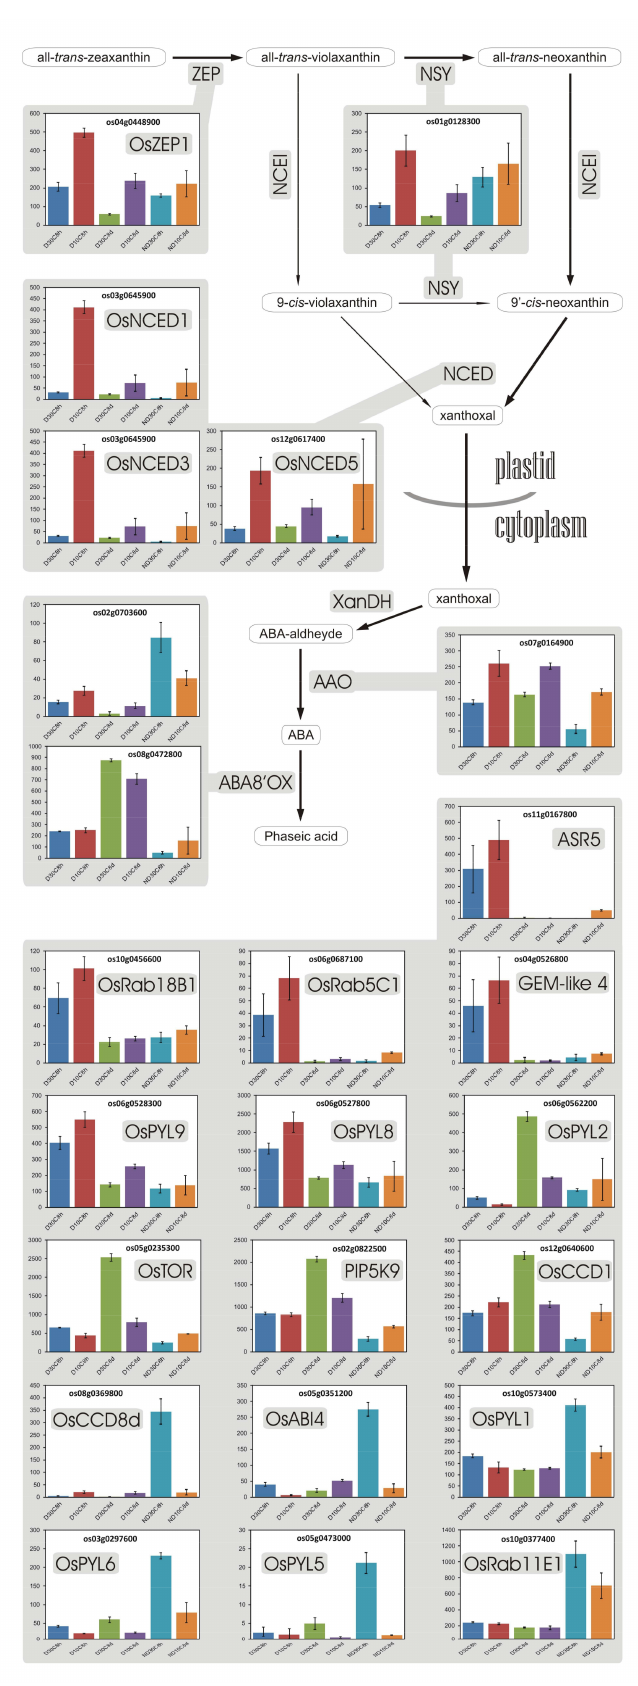
Figure 7. Expression levels (left scale on the y-axis of each plot) of DEGs involved in abscisic acid